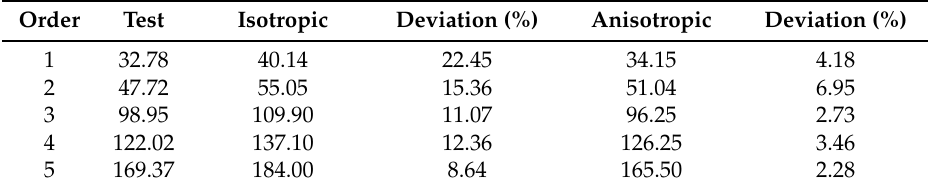
Figure 19. Comparisons of mode shapes of the oil cooler cover between tested and simulated results. Table 3. Comparisons of modal frequencies of the oil cooler cover between tested and simulated results. Order